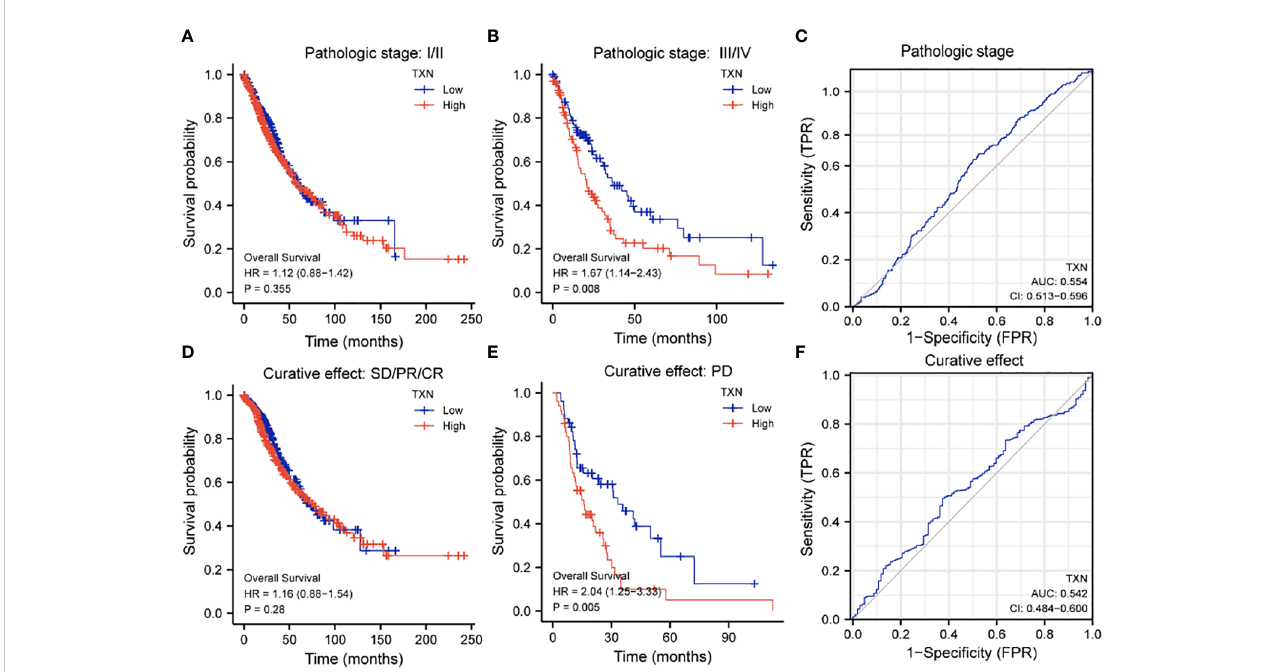
FIGURE 9 Relationships between TXN expression with T-stage and curative outcomes in lung cancer patients. (A, B) KM survival analysis of the relationships between TXN expression and survival in patients with T-stage (A) I/II and (B) III/IV tumors. (C) ROC curve analysis of the relationship between TXN expression and T stage. (D, E) KM survival analysis of the relationships between TXN expression and patients who achieved (D) SD, PR, and CR and (E) PD. (F) ROC curve analysis of the relationship between TXN expression and patient curative outcomes.